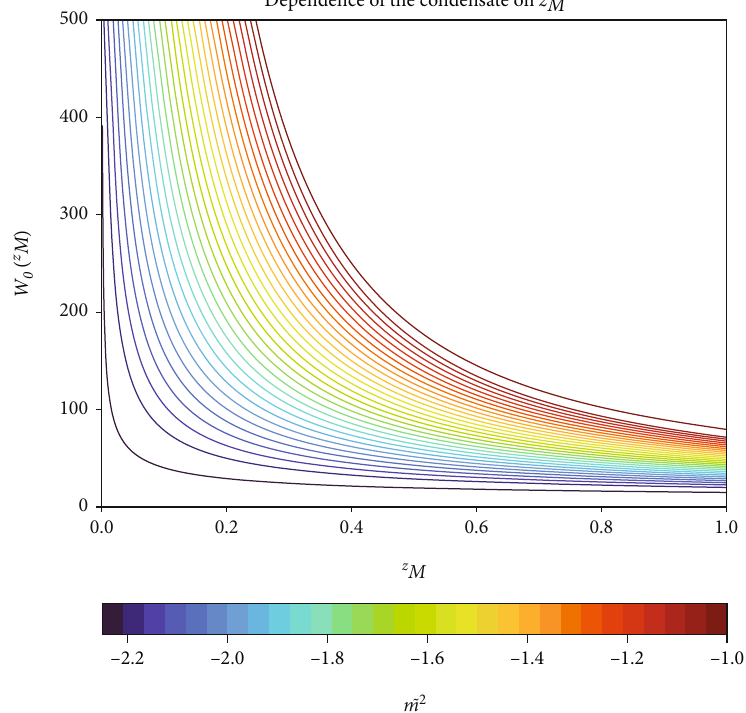
Figure 5: Comparison of the real and imaginary part of the conductivity for the analytical and numerical approach. Note that the real part of the conductivity is plotted logarithmically, while the plot of the imaginary part employs a linear scale. Notice also how in the low frequency region, the analytical σ reproduces the features of the numerical one to some extent. However, its behaviour is completely faulty for ω > ω g